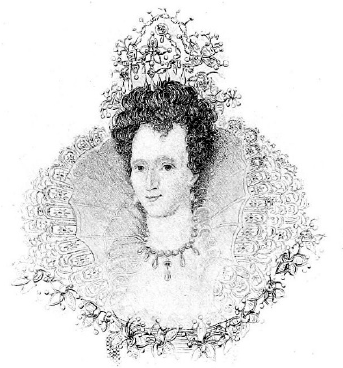
Figure 1. Elizabethan collars are named after lace collars or ruffs worn during the era of Queen Elizabeth I, as illustrated in this portrait of Queen Elizabeth (source: https: // commons.wikimedia.org / wiki / File:Two_Portraits_of_Queen_Elizabeth,_Illustrating_Wide_ Ru ff _and_Headress-_Elizabethan_People_(book).jpg; https: // archive.org / details / cu31924027958630).